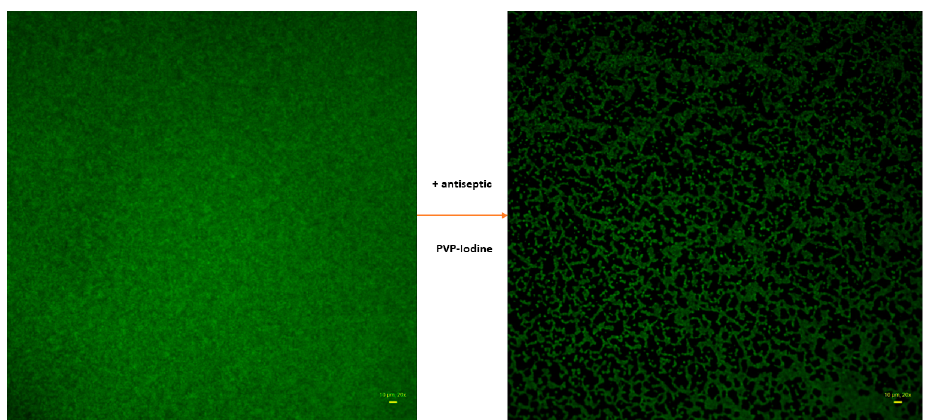
Figure 8. Staphylococcal biofilm of the ATCC 6538 strain non-treated (left picture) and treated (right picture) with an antiseptic (PVP-iodine). Biofilms dyed with SYTO-9 only. Aerial perspective, epifluorescent microscopy. Data collected with wide-field Lumascope 620 magnification 20×, scale bar is 10 µm.